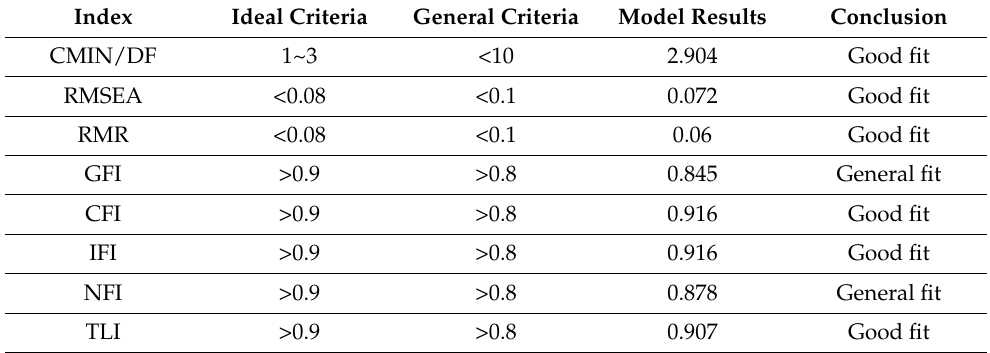
Table A8. Model fitting